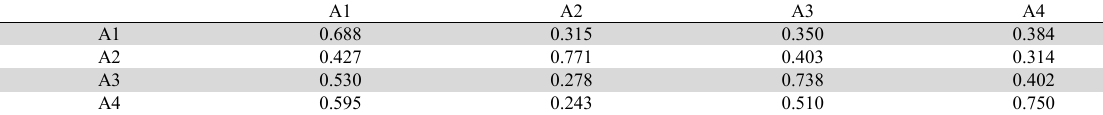
Initial direct relationship matrix of attributes